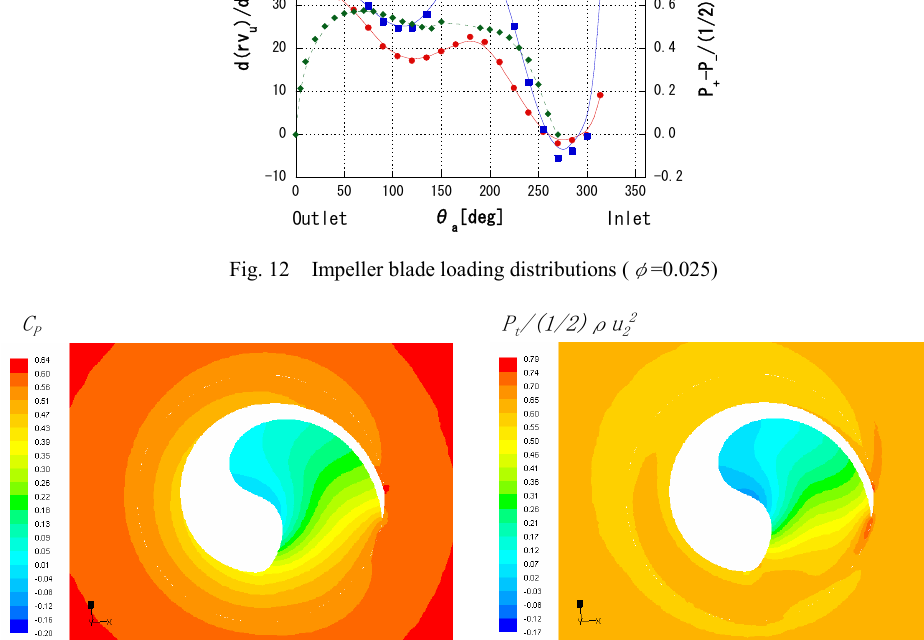
Fig. 13 Static pressure distributions ( φ =0.025) Fig. 14 Total pressure distributions ( φ